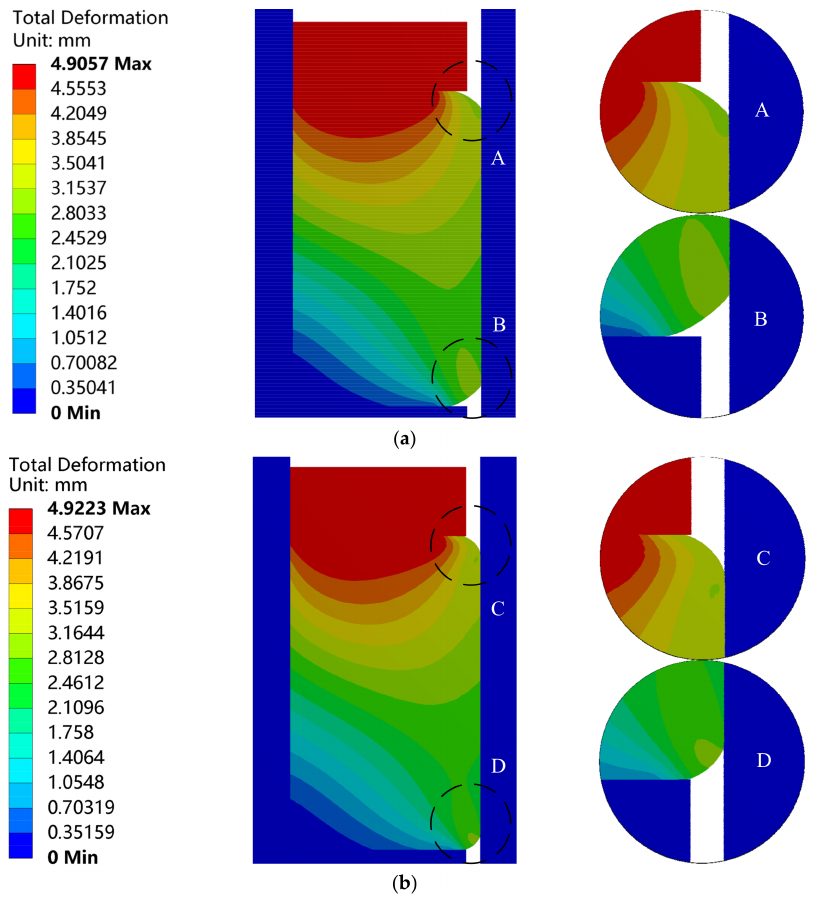
Figure 9. Comparison of deformation before and after optimization. ( a ) Diagram of deformation before optimization; ( b ) Diagram of deformation after